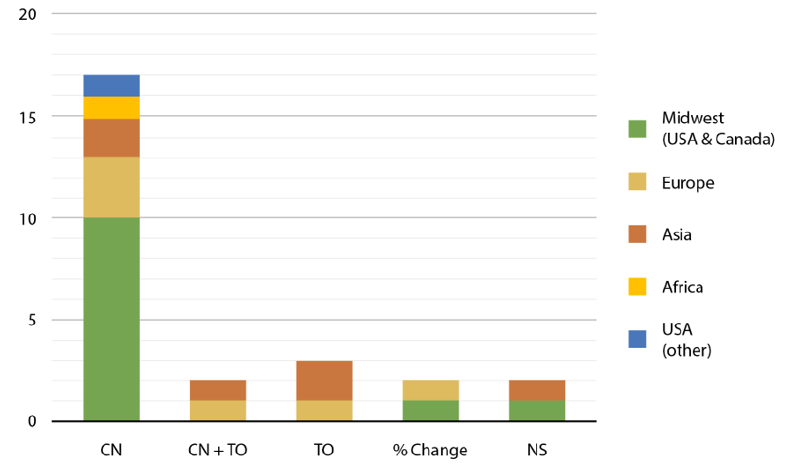
Figure 2. Literature review results of 25 articles outlining the incorporation of agricultural conserva- tion practices into SWAT.